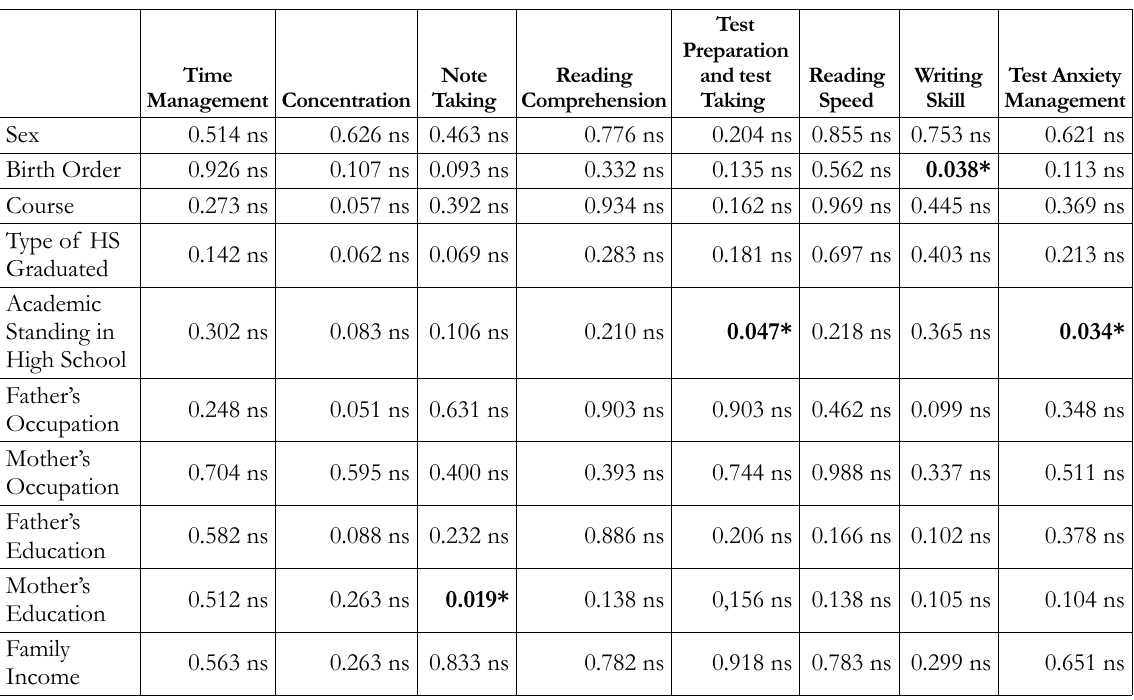
Table 6. Test of Difference on the Study Habits of the Respondents